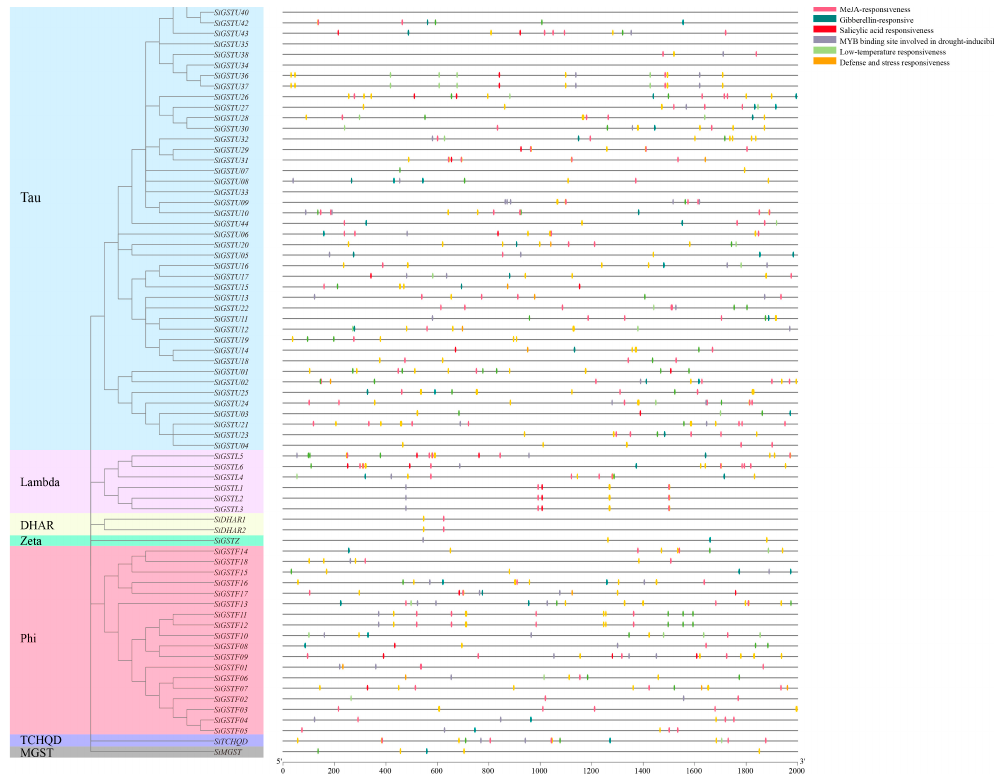
Figure 4. Predicted cis-acting element in SiGST promoter of foxtail millet.